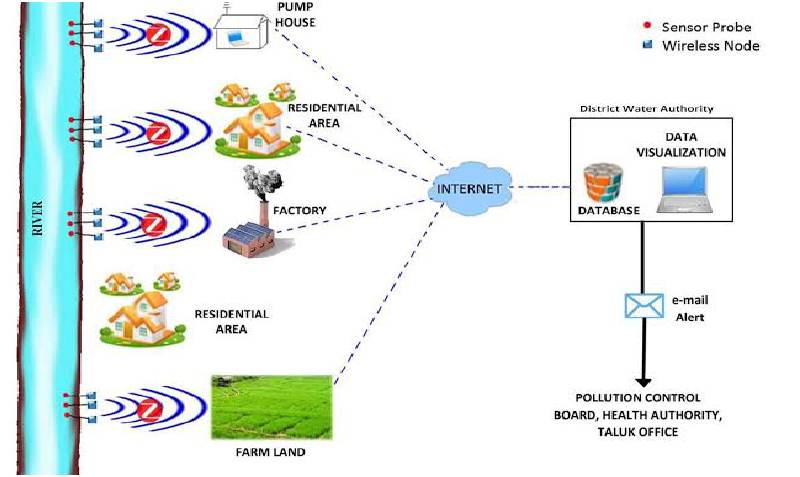
Figure 7. A typical smart water monitoring system using